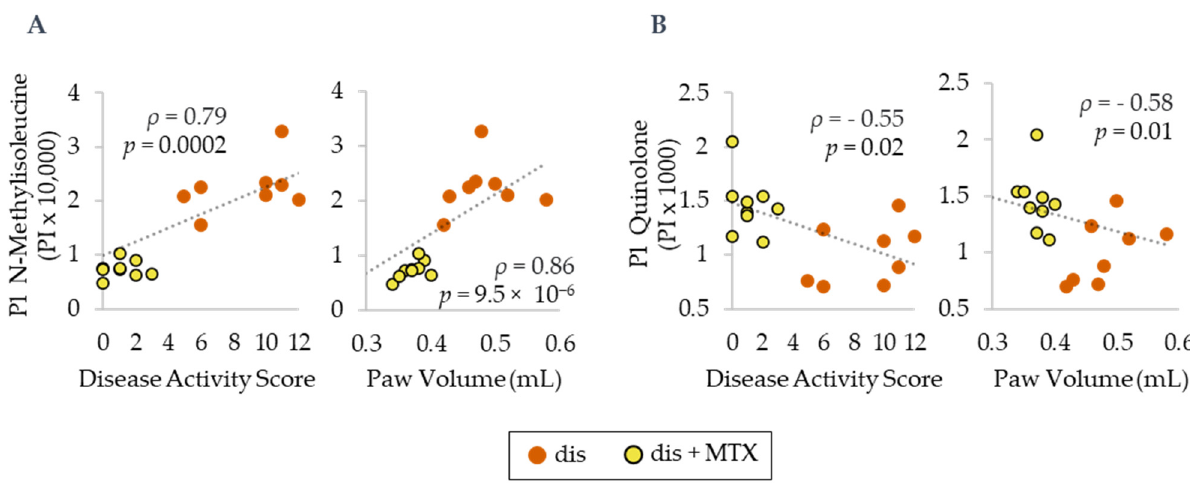
Figure 6. Spearman’s correlations for plasma metabolite levels in normalized peak intensity (PI) of ( A ) N-methylisoleucine and ( B ) quinolone with PV and DAS. Dis (orange; n = 8) and dis + MTX (yellow; n = 9).